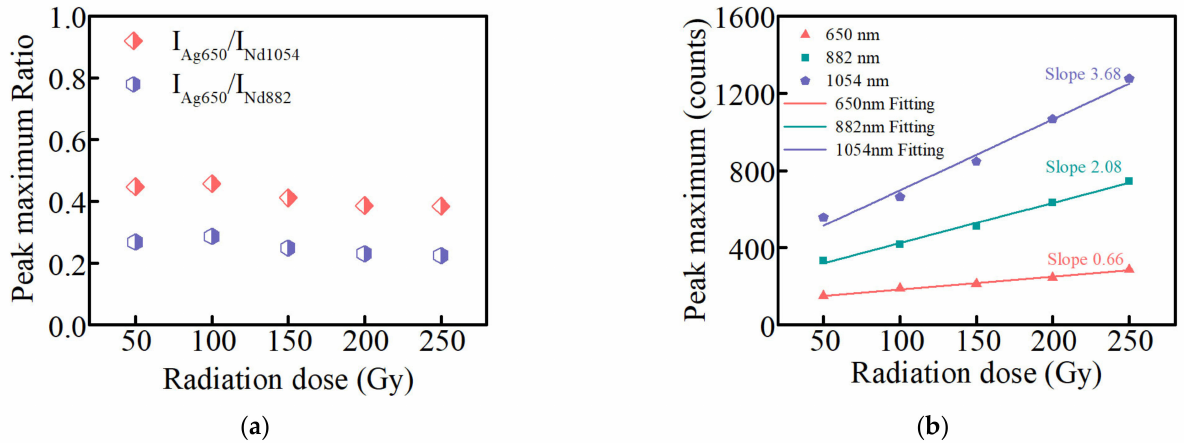
Figure 4. ( a ) the peak maximum ratio of Ag defect center at 650 nm to that of Nd 3+ ions at 882 and 1054 nm at different radiation doses; ( b ) the linear relationship between the RPL peak maximum intensity of Ag defect centers at 650 nm and the fluorescence peak maximum intensity of Nd 3+ ions at 882 and 1054 nm and the radiation dose in Ag–Nd-codoped phosphate glasses (310 nm